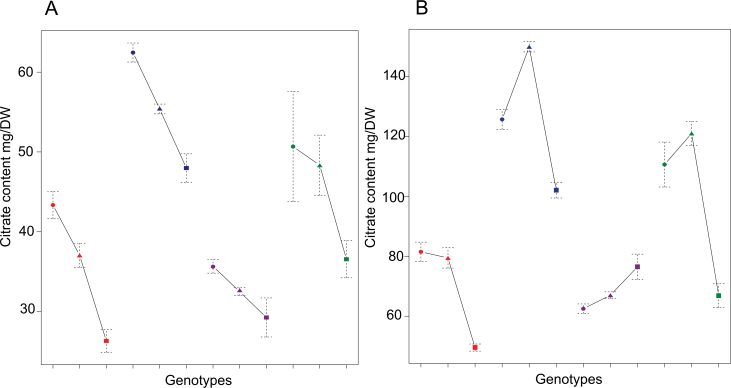
Inheritance of citrate content in tomato fruit at (A) the cell expansion stage and (B) the orange-red stage. Genotypes are indicated with different symbols, S. lycopersicum squares, S. lycopersicum var. cerasiforme circle, and F1 triangles. From left to right: Levovil×Cervil, Stupicke Polni Rane×Criollo, LA0147×Plovdiv 24A, and Ferum×LA1420. (This figure is available in colour at JXB online.)